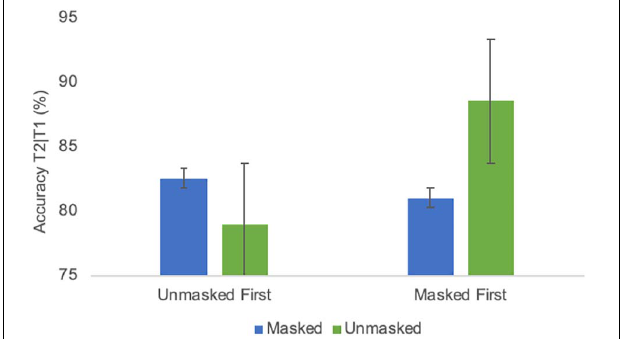
FIGURE 8 | Average identification accuracy of T2 in different masking conditions of Experiment 2 in a group comparison (starting with the unmasked condition/starting with the masked condition). Error bars represent one standard error of the